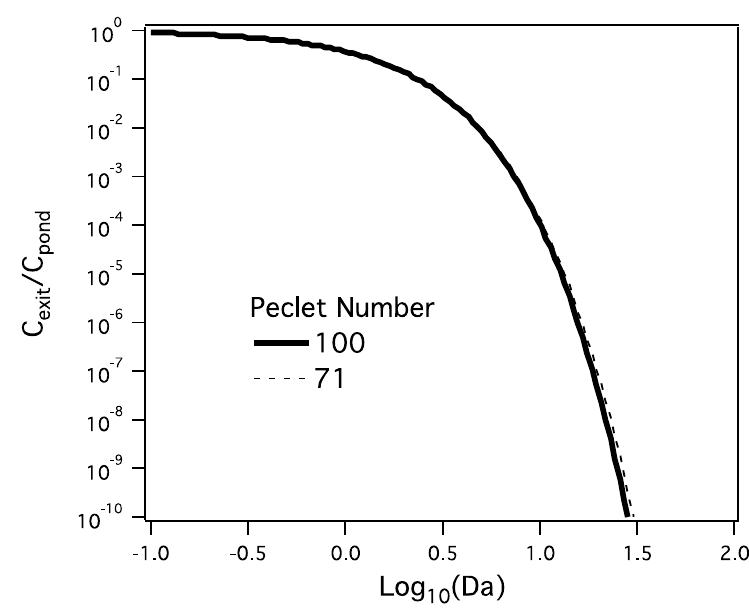
Figure 4. Relationship between Peclet number, Damkohler number and percentage of removal of microbial contaminants.